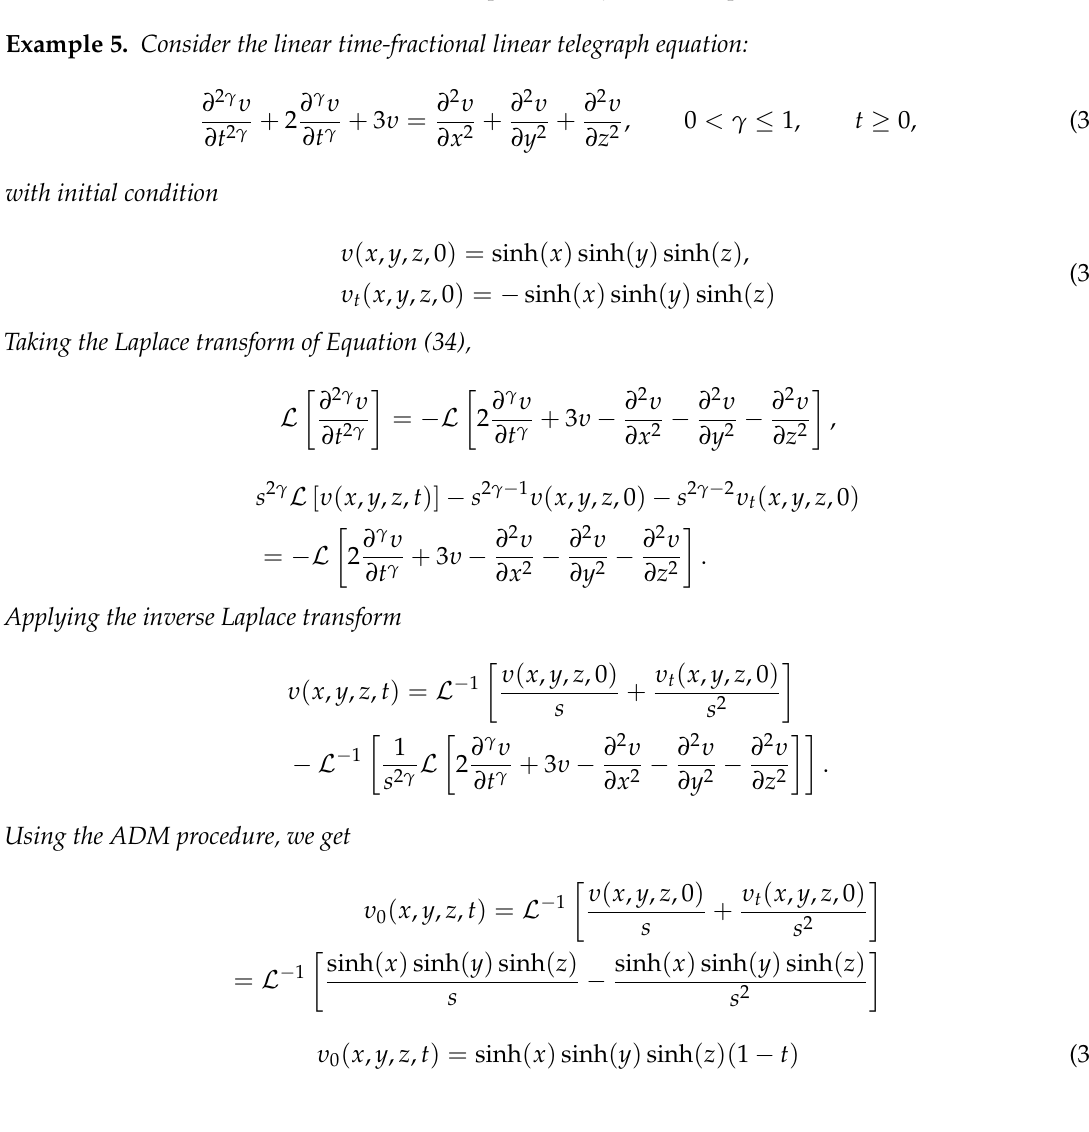
Figure 10. The (a) Error plot of υ ( x , y , t ) of Example 4 at γ =